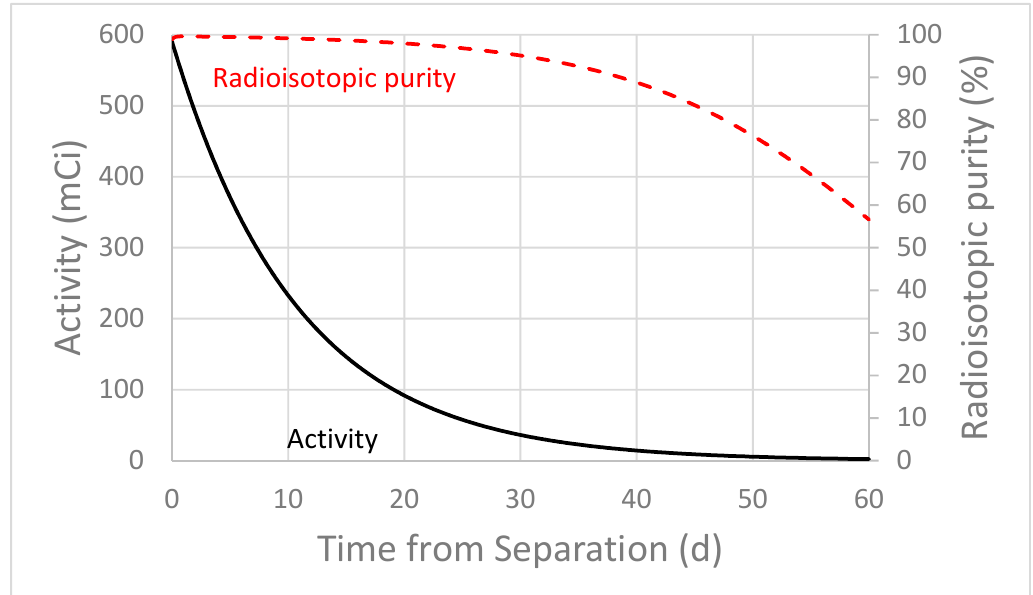
Figure 3. MCNP6 and experimentally calculated radioisotopic purity of Ag-111. Calculations assume silver purified from Ac-225 waste streams and irradiation parameters specified in the caption for Table 3.